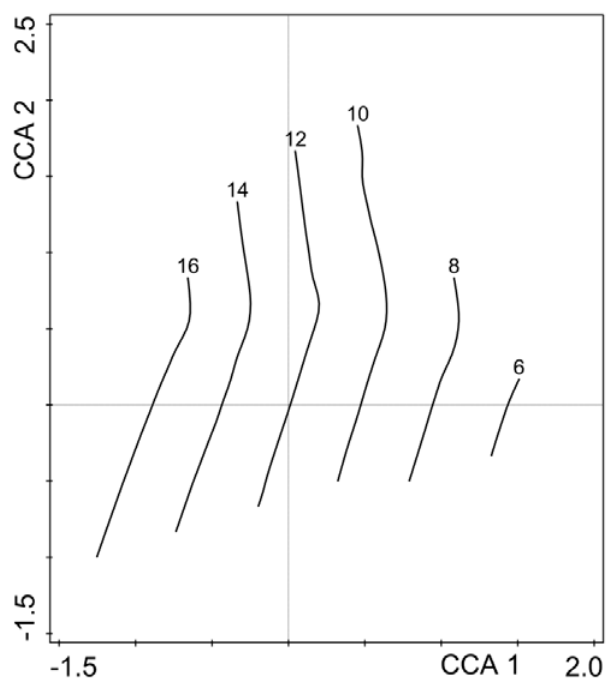
Figure 6. Isolines indicating epiphytic bryophyte species richness through the CCA ordination space. Loess smoothing model was used.